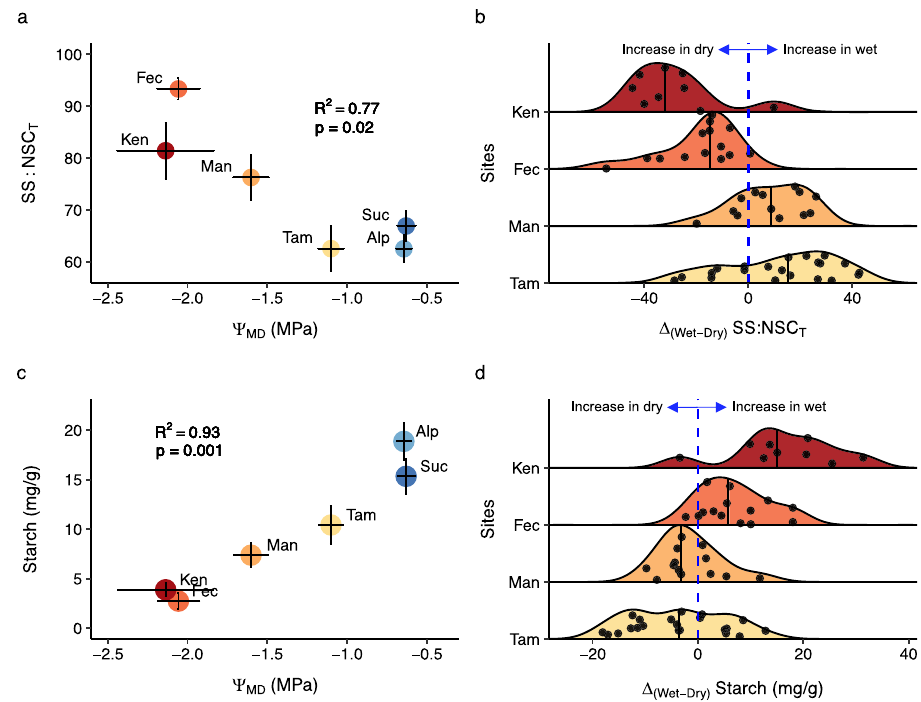
Fig. 4 Relationship between leaf NSC and water status, and distributions of species-level seasonal shifts in leaf NSC allocation. Relationship between a leaf SS:NSC T (proportion of leaf NSC T in the form of soluble sugars) and midday leaf water potential ( Ψ MD ); c leaf starch and Ψ MD. Distributions of species-level seasonal shifts in b leaf SS:NSC T allocation (SS:NSC T Wet − SS:NSC T Dry ) and d starch allocation (starch wet − starch dry ). In the panel a and c the SS:NSC T , starch and Ψ MD represent mean of all species sampled in each site in the dry season, except in the two sites where there is no dry season (monthly precipitation ≤ 100 mm month − 1 ). Vertical and horizontal bars denote one standard error of the mean. The relationship between SS:NSC T , starch and Ψ MD was fi tted using standardised major axis (SMA) regression. In the panel b and d sites are ordered from top to bottom from drier to wettest. Long vertical black line denotate the mean Δ SS:NSC T and starch, each dot represents one species. Values to the left of the blue line denote species that increased SS:NSC T and starch in the dry season while those to the right of the line increased SS:NSC T and starch in the wet (Fig. 4a; p = 0.02, R 2 = 0.77). This relationship also exists when